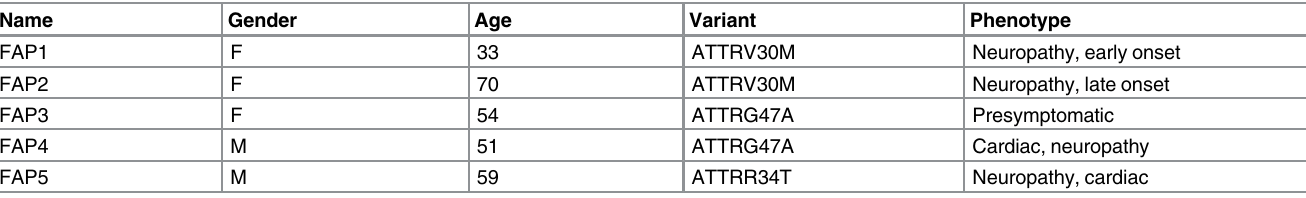
Table 1. Characteristics of FAP